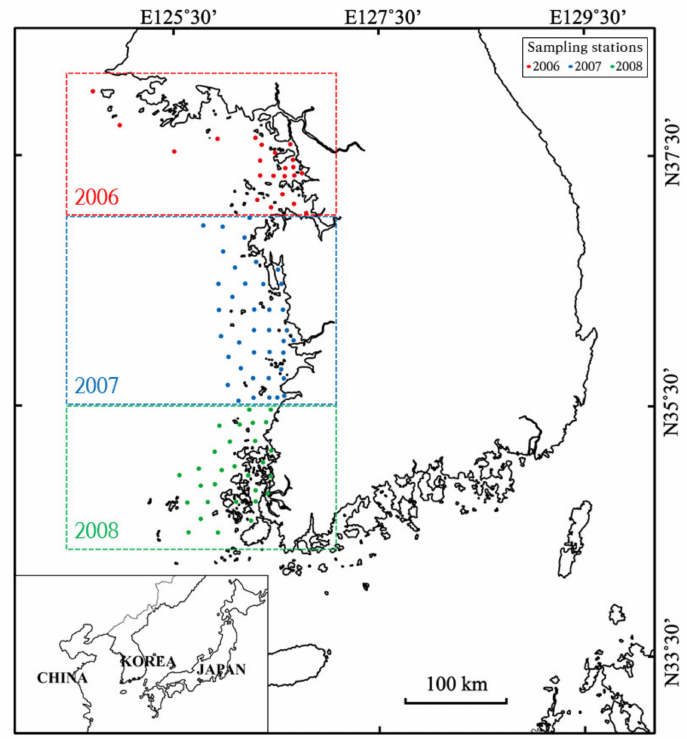
Figure 1. Study area on the west coast of Korea. A total of 93 stations were established and sampled seasonally from 2006 to 2008. Circles on the map indicate the sampling station